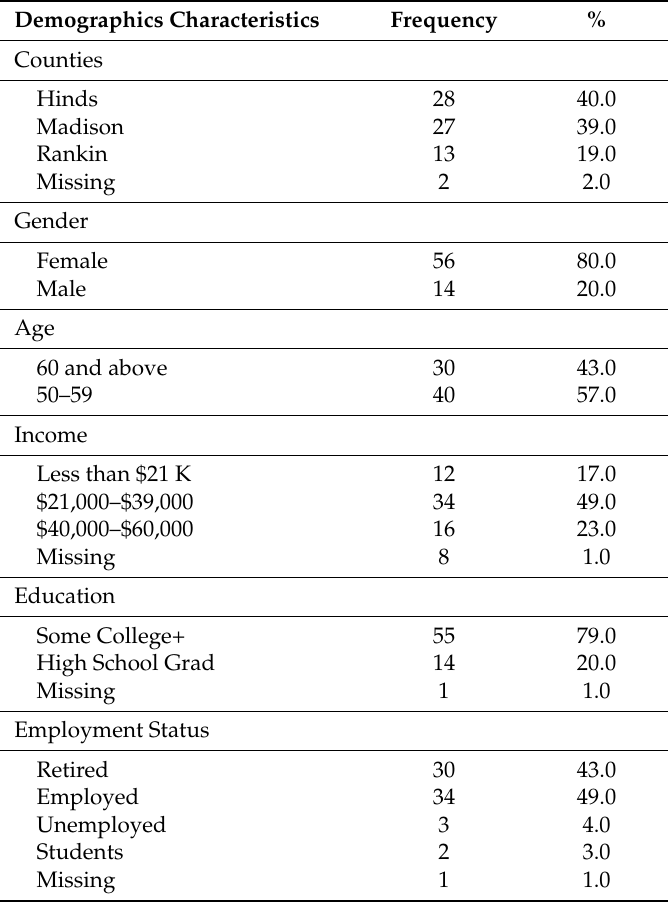
Table 2. Focus Group